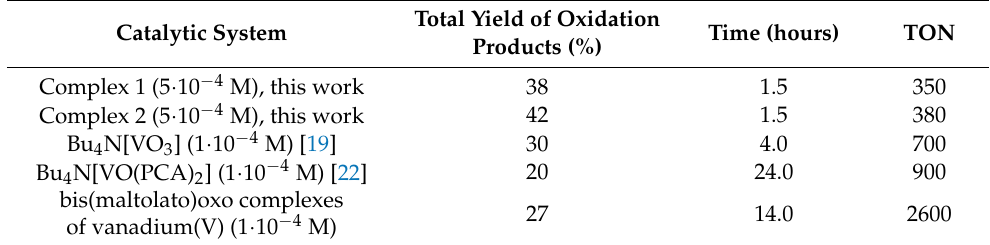
Table 2. Comparative parameters of the oxidation of cyclohexane catalyzed by complexes 1 and 2 and other previously published vanadium